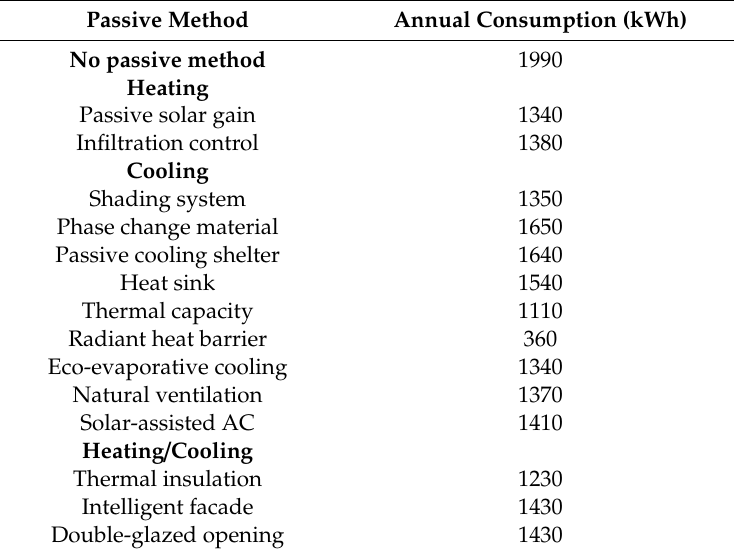
Table 9. Annual energy consumption by using di ff erent passive methods.